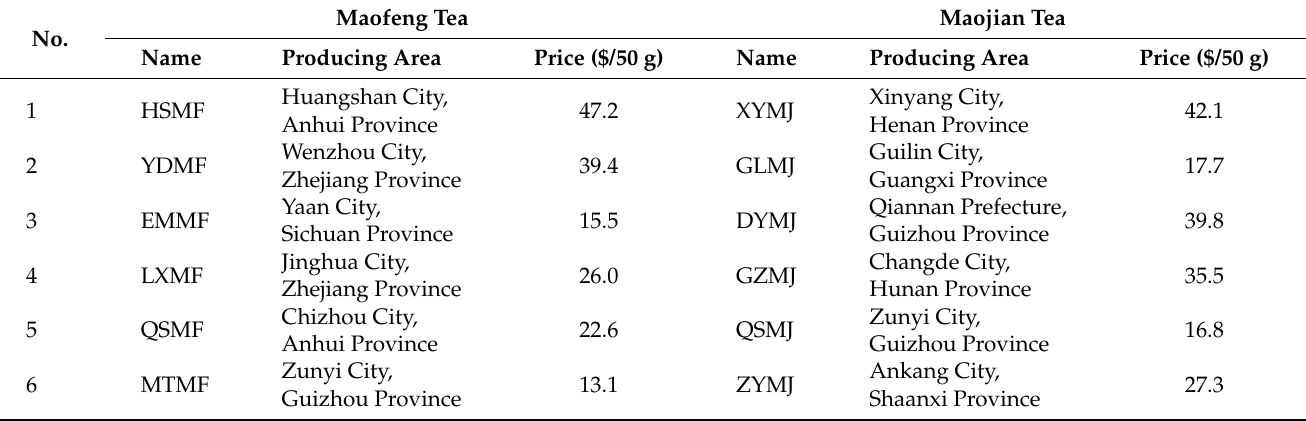
Table 1. Details of the 12 tea